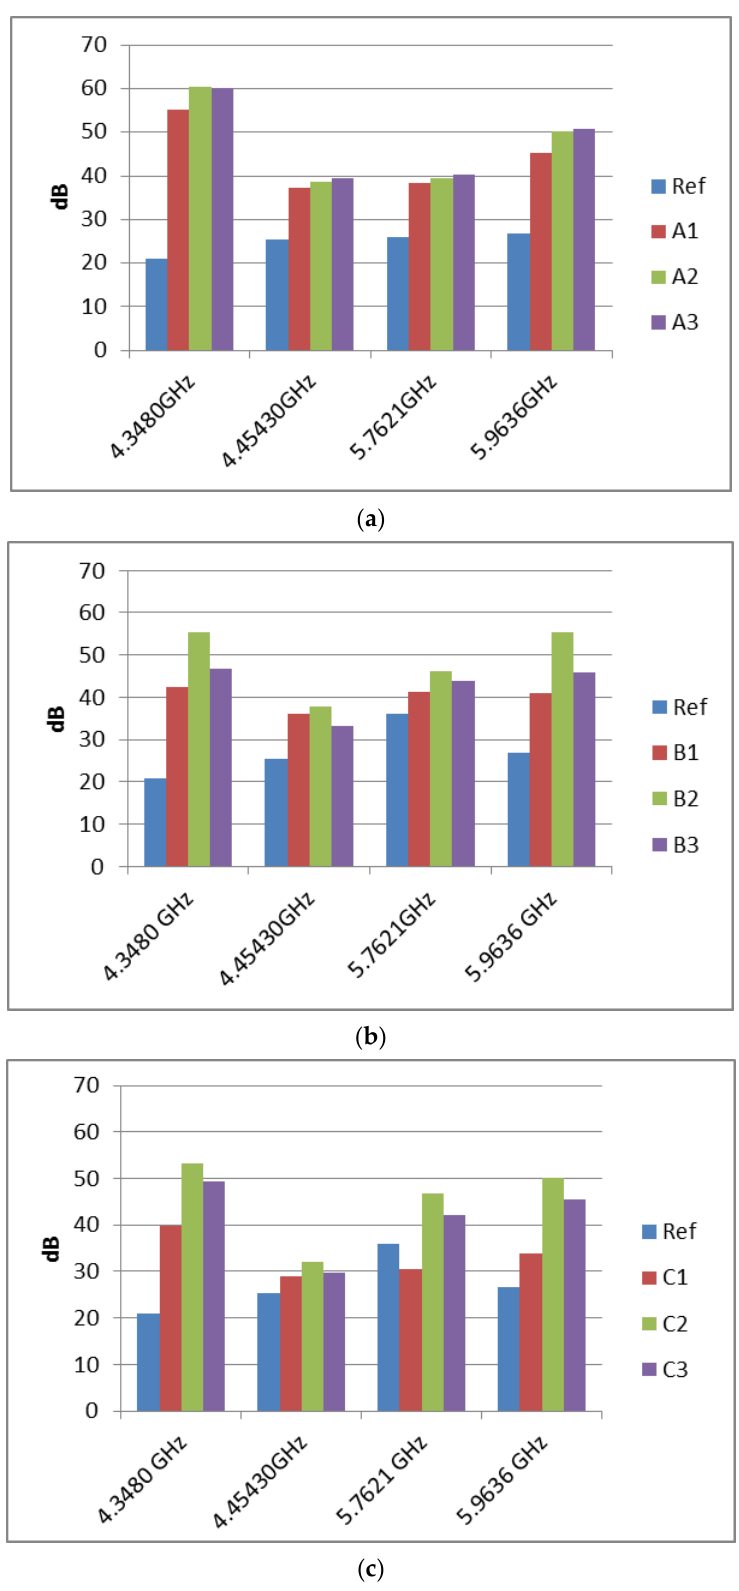
Figure 9. Comparison of the EMI absorption (parameter S 12 ) for the three ( a ) HCl and ( b ) HBr and ( c ) PSS-doped PANI/graphene/PEDOT:PSS water-based formulation, using one, two, and three layers from each type.